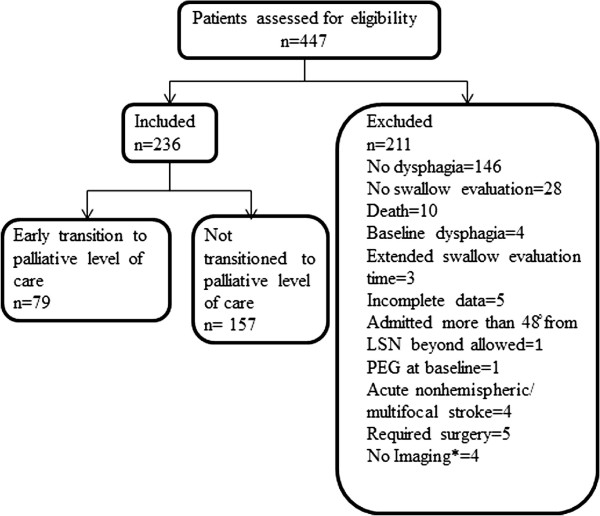
Subject selection. LSN = last seen normal, PEG = percutaneous endoscopic gastrostomy.